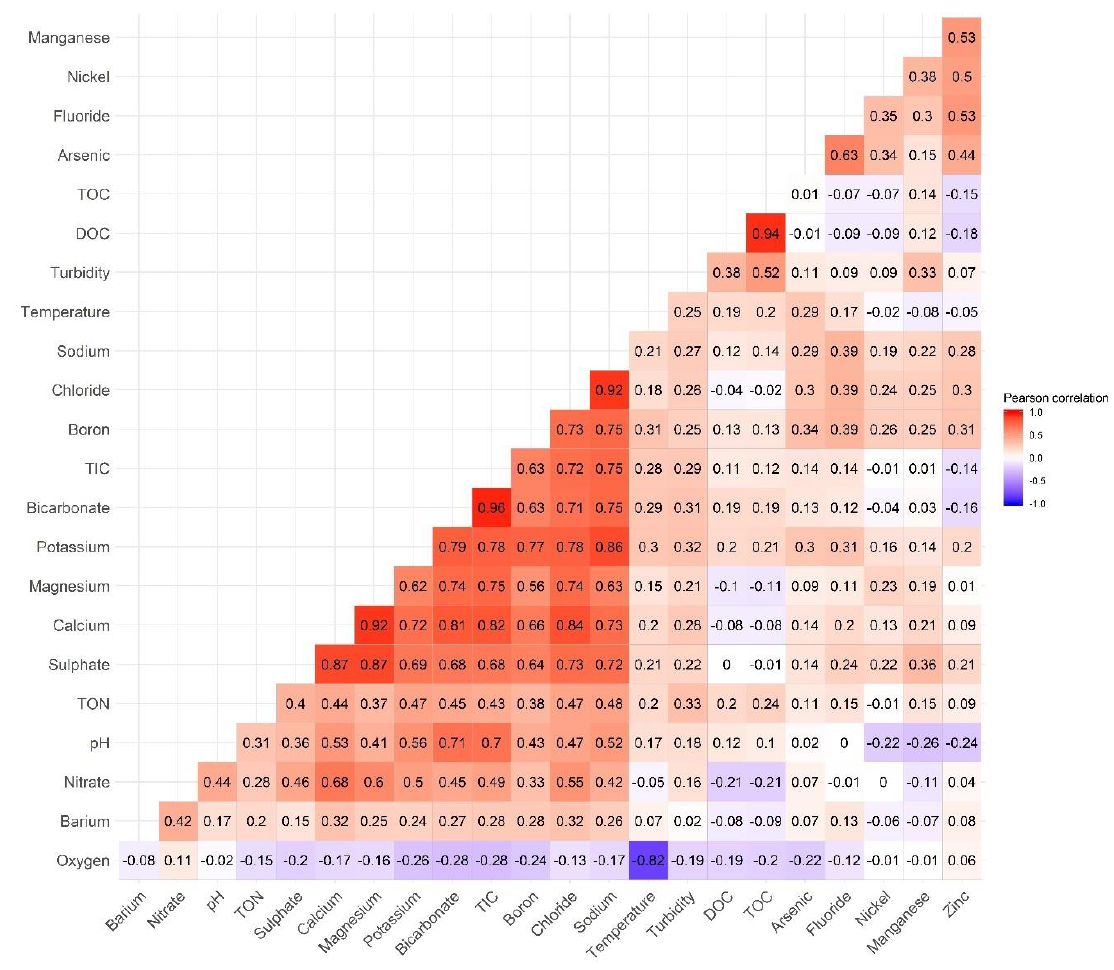
Figure 3. Pearson correlation matrix of 23 parameters during the whole monitoring period. The numbers are correlation coefficients.